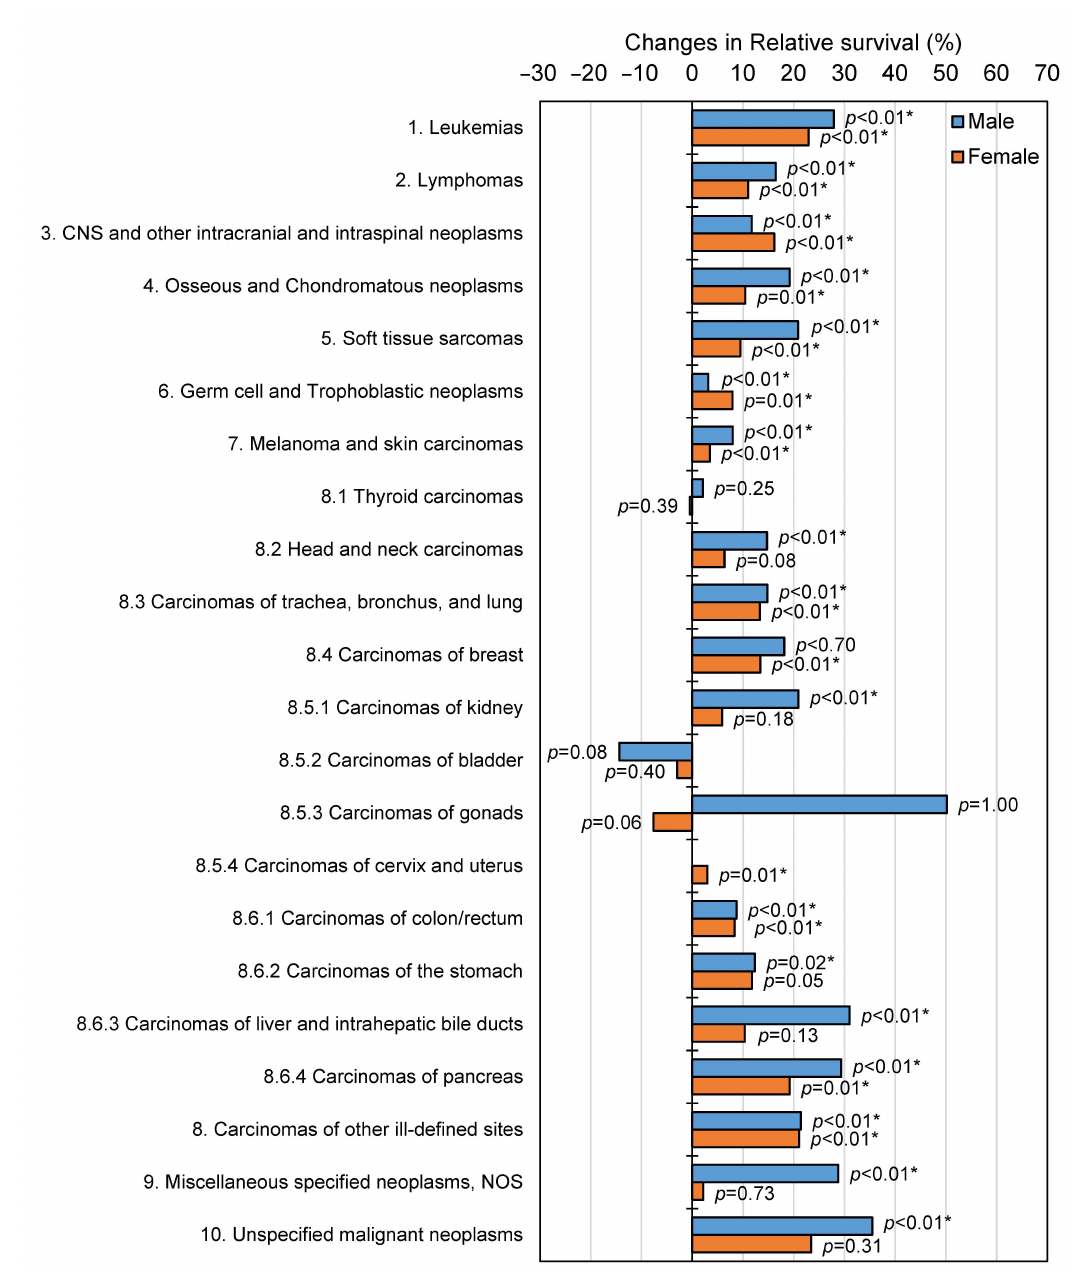
Figure 4. Cancer type specific changes (%) in five-year relative survival outcomes between 1990–1999 and 2010–2016 for male and female adolescent and young adult (AYA) cancer patients diagnosed in the Netherlands between 1990–2016. p -values were obtained from a likelihood ratio test comparing a model including the midpoint of the calendar period and a model without calendar period. A p -value < 0.05 was considered to be statistically significant (denoted with